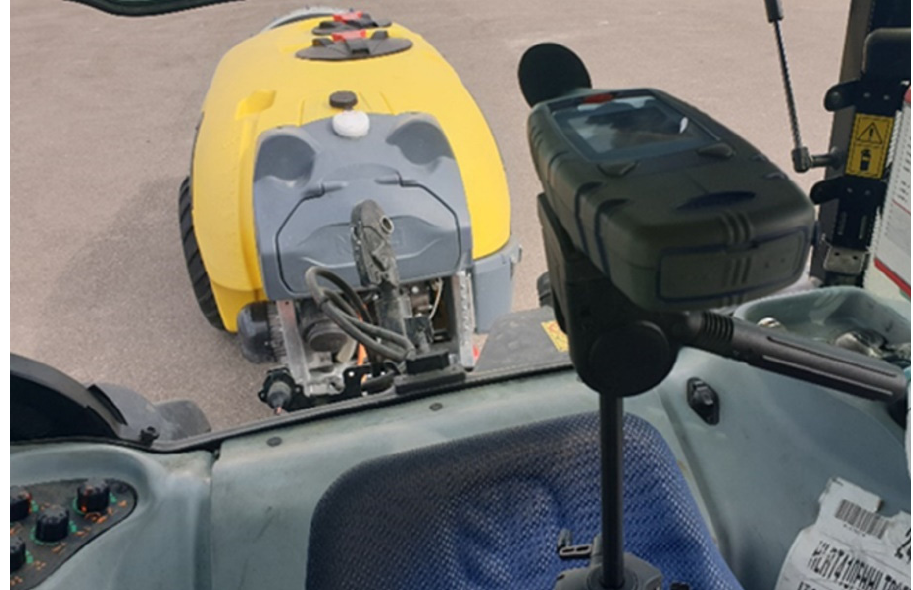
Figure 7. Casella CEL-246 phonometer and eSprayer during the noise test.